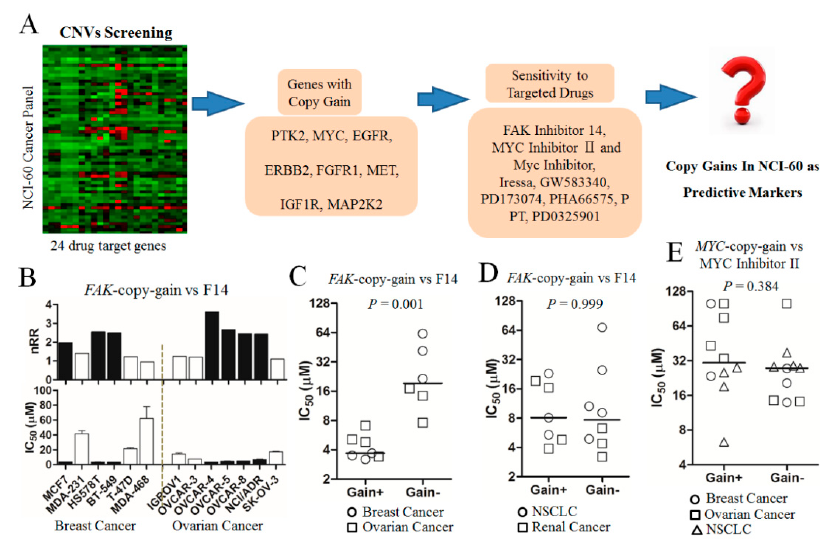
Figure 1. Screening of candidate predictive marker genes. ( A) Scheme for screening of copy-gain predictive markers. The copy numbers of 24 drug-target genes in an NCI-60 cancer panel had previously been measured by mrcPCR [10]. For eight copy-gain genes in the NCI-60 cells, their targeted drugs were employed for the selection of predictive markers. After determination of IC 50 for the targeted drugs in cells showing copy gains of target genes, copy-gain predictive markers were analyzed. ( B ) Lower IC 50 for Focal Adhesion Kinase (FAK) inhibitor 14 (F14) in FAK-copy-gain breast and ovarian NCI-60 cells. Cells with FAK-copy-gain, black bars; cells without copy gain, white bars. nRR: normalized relative ratio of copy number. MDA-231 and MDA-468 in cell line list are MDA-MB-231 and MDA-MB-468, respectively. ( C) Significantly lower IC 50 for F14 in cells with FAK-copy-gain in breast and ovarian cancer cells ( P < 0.001, Mann–Whitney U test). ( D) No significant correlation between FAK-copy-gain and sensitivity to F14 in non-small-cell lung cancer (NSCLC) and renal cancer cells ( p = 0.999). For C–D, cells with FAK-copy-gain are marked as Gain+, and those without copy gain as Gain-. ( E) No significant correlation between MYC-copy-gain and sensitivity to MYC Inhibitor II in breast, ovarian, and NSCLC cancer cells ( P = 0.384). Cells with MYC-copy-gain are marked as Gain + , and those without copy gain as